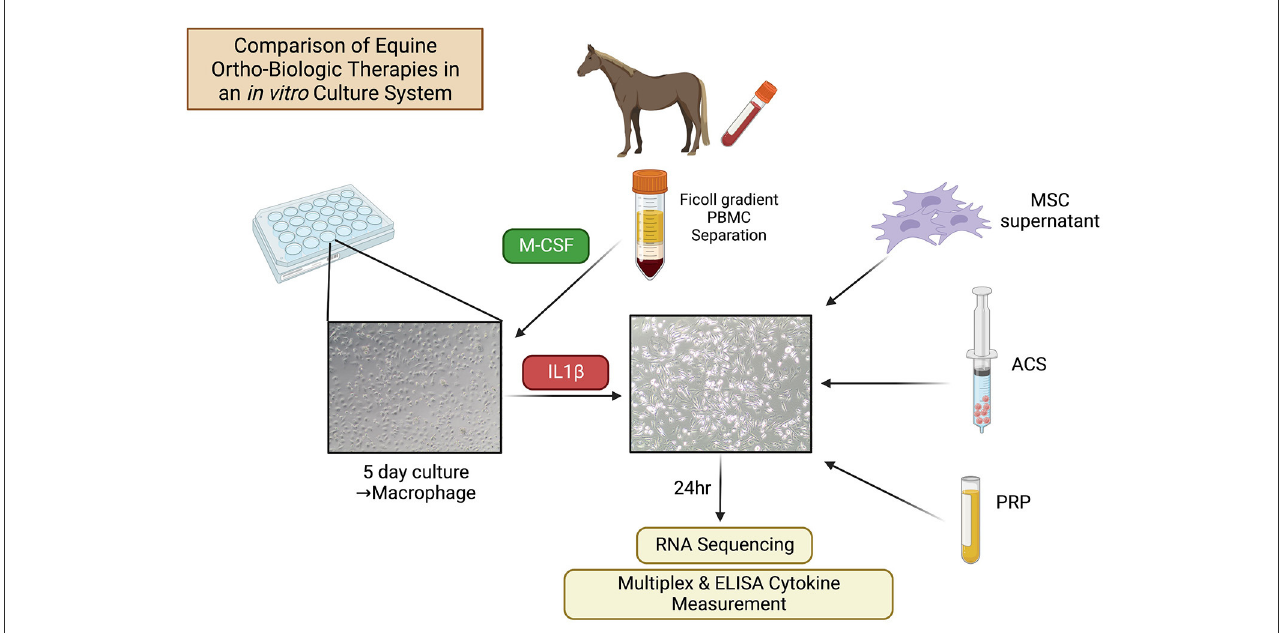
FIGURE1 Schematic of study design. Equine macrophages were generated from PBMC by adherence of the monocytes, followed by treatment with M-CSF. After 5 days in culture, macrophages were stimulated with IL-1ß (10ng/ml) and orthobiological therapies (MSC-CM, PRP, ACS) from n = 3 donor horses were added to macrophage cultures at 1:3 cell ratio. After 24h of treatment, macrophages were washed with PBS and cultured in complete media an additional 24h, at which time supernatants were collected for cytokine analysis and macrophage cells were collected for RNA